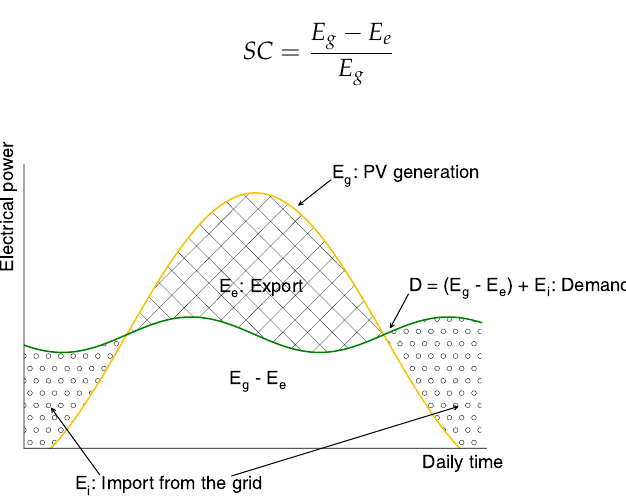
Figure 12. Self-sufficiency and self-consumption visual depiction.